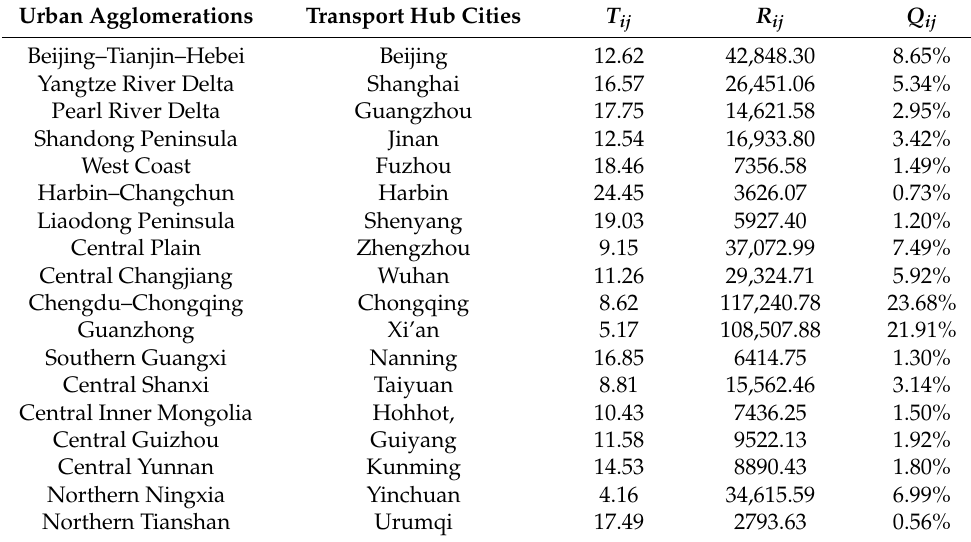
Table 4. Strength of economic ties and subordination between Lanzhou and urban agglomerations of the other 18 node